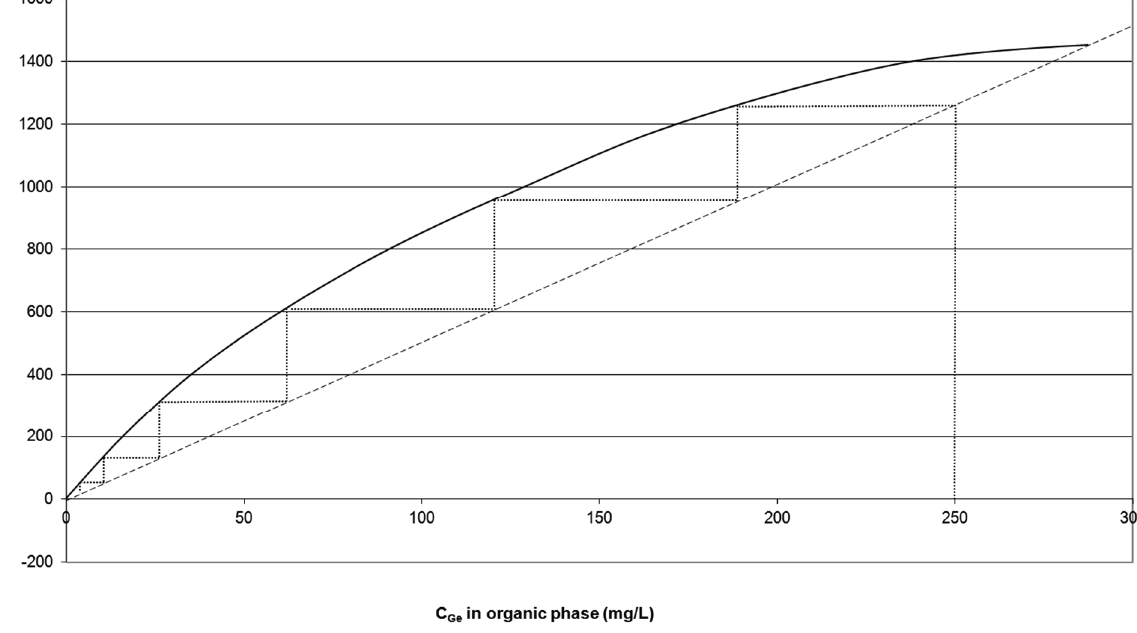
Figure 4. McCabe-Thiele diagram of stripping